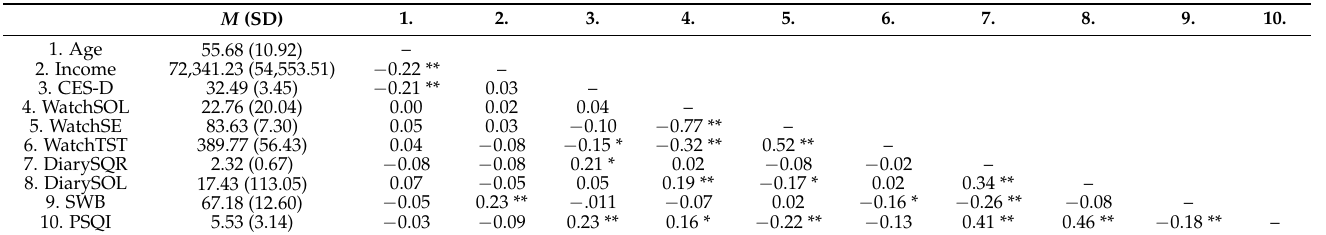
Table 2. Descriptive statistics and bivariate correlations of study variables.